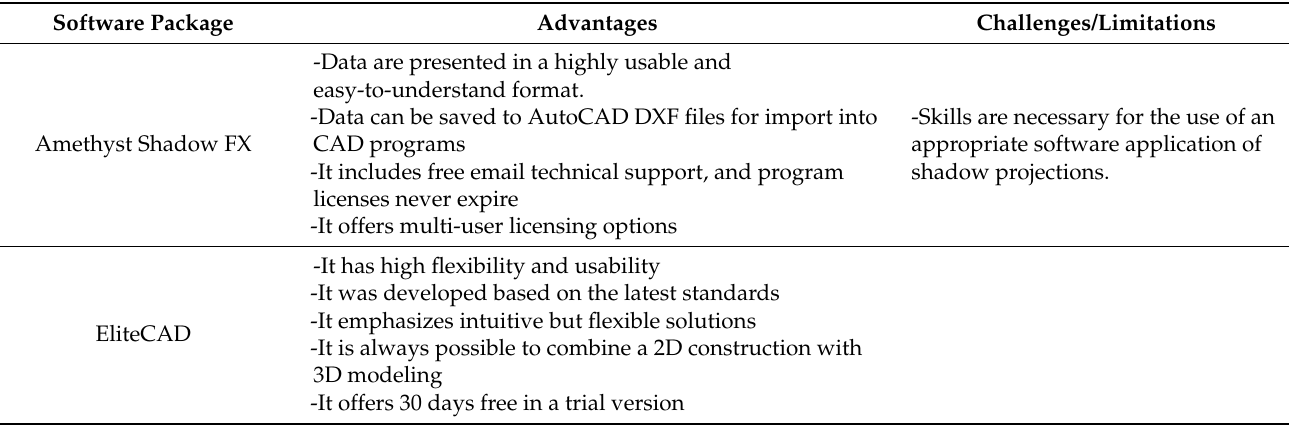
Table 2. Advantages and challenges of heliodon software